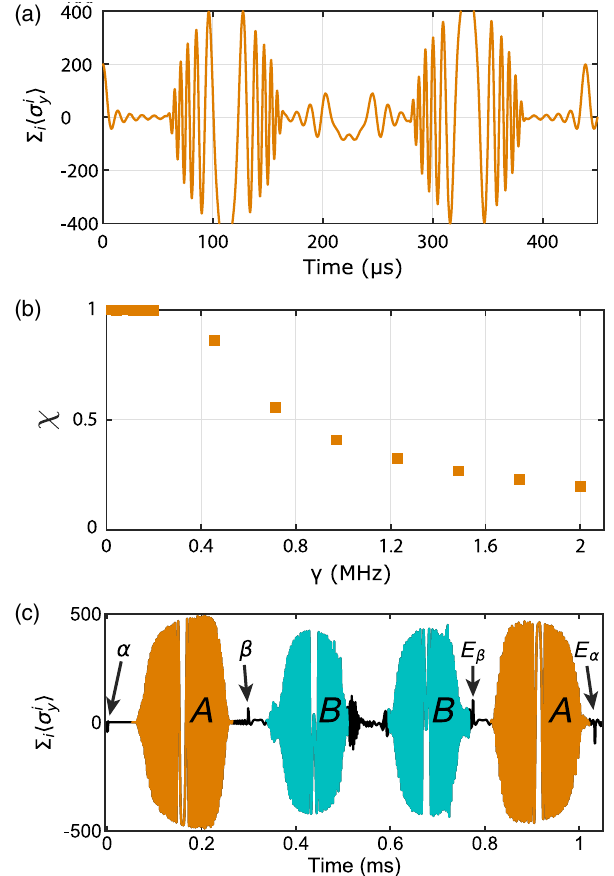
FIG. 2. Simulation of the memory protocol. Numerical simu- lations of 3 . 23 × 10 5 spins with 100 kHz linewidth showing the effects of a WURST pulse on a large ensemble of emitters. i summed over all spins show that, (a) Expectation values h ˆ σ i y following a pair of identical WURST pulses, an initial excitation is faithfully recovered as an echo. (b) The ratio of the excitation to echo amplitude ( χ ) is shown as a function of the spin linewidth γ for a WURST pulse of 0.5 MHz bandwidth. For spin line- widths within the WURST bandwidth the sequence has approx- imately unit efficiency. (c) Retrieval of two weak excitations within an ABBA sequence composed of two different WURST ¼ − 2 π × pulses ( A and B ) with different chirp rates, R A 11 . 25 MHz = ms and R ¼ 2 π × 7 . 50 MHz = ms. Two weak B pulses, α and β , are stored in the spins and reemitted at the expected times as echoes E α and E β .